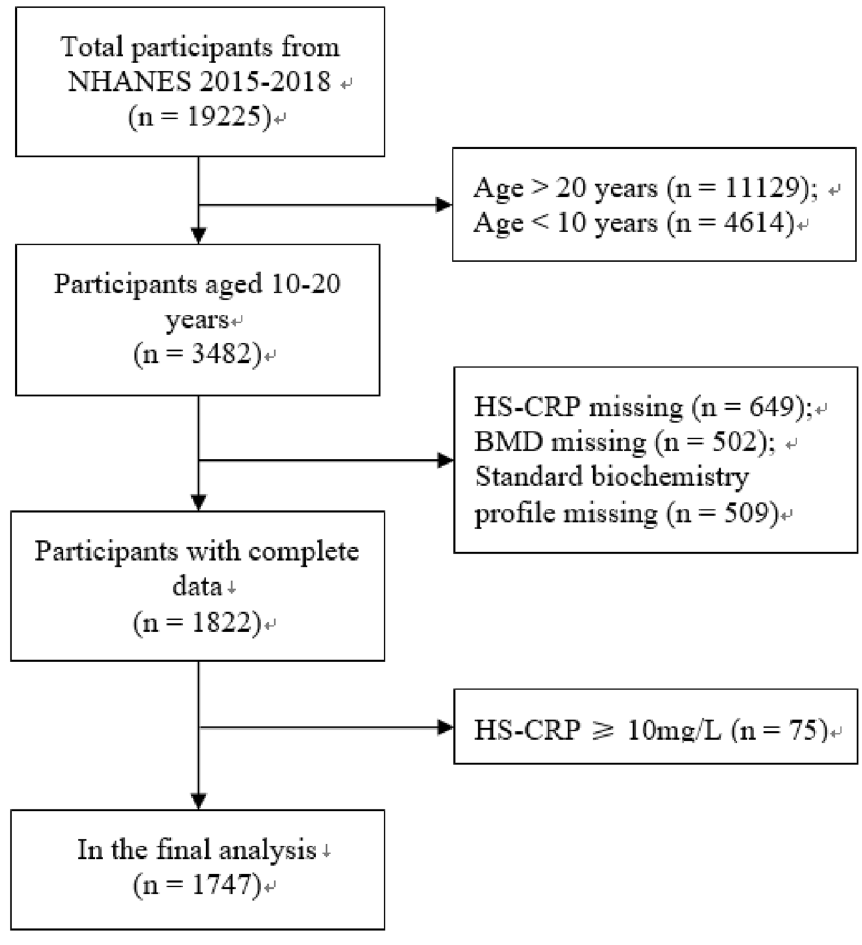
Figure 1. Flow chart of sample